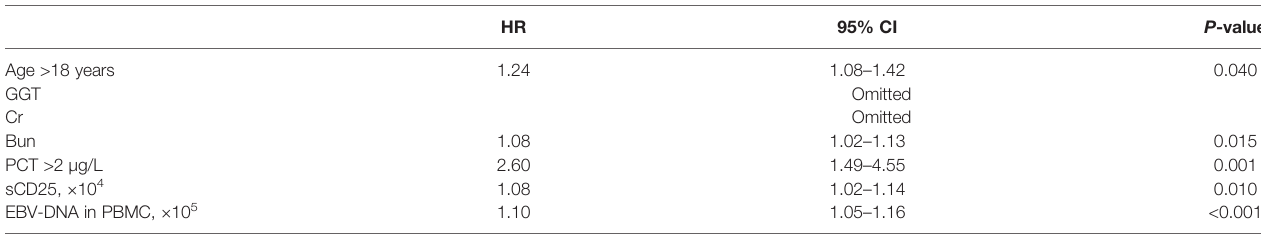
† for the risk factors associated with the survival in induction therapy based on primary cohort.